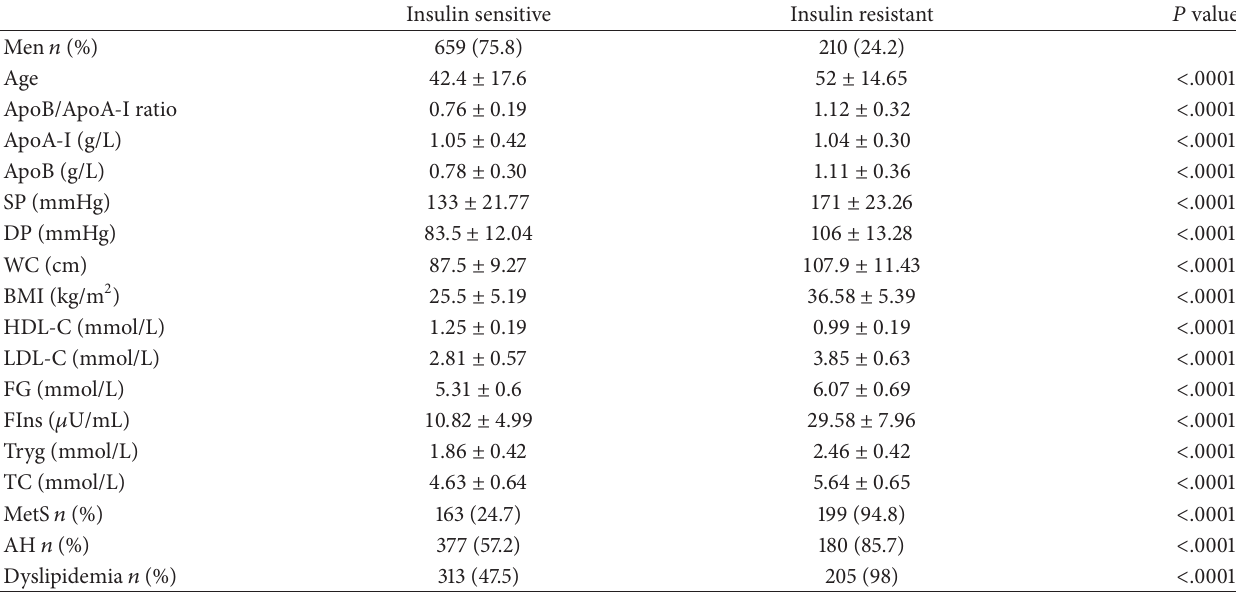
Table 3: Descriptive characteristics between insulin resistant and insulin sensitive (men).